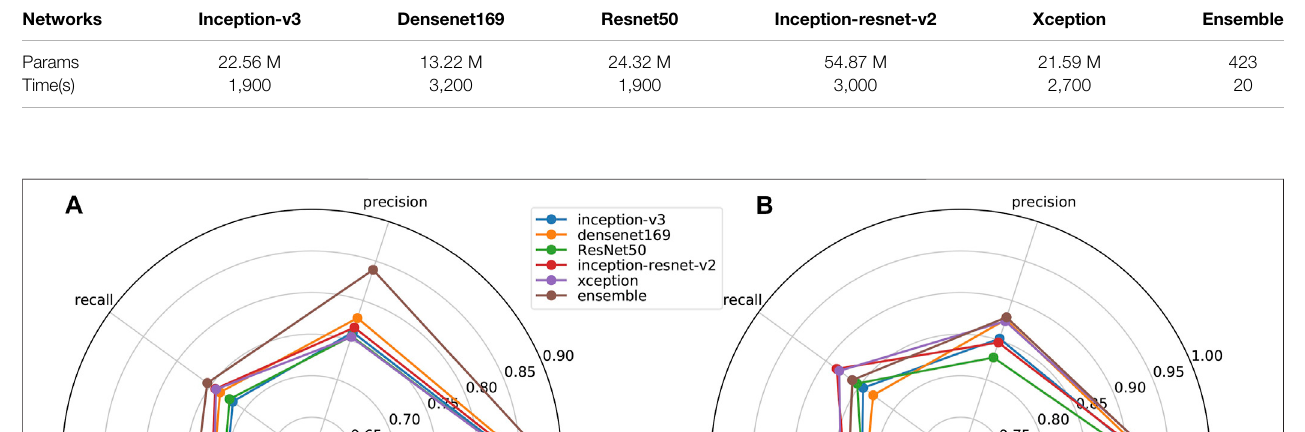
TABLE 4 | The amount of parameters and the training time of each network.